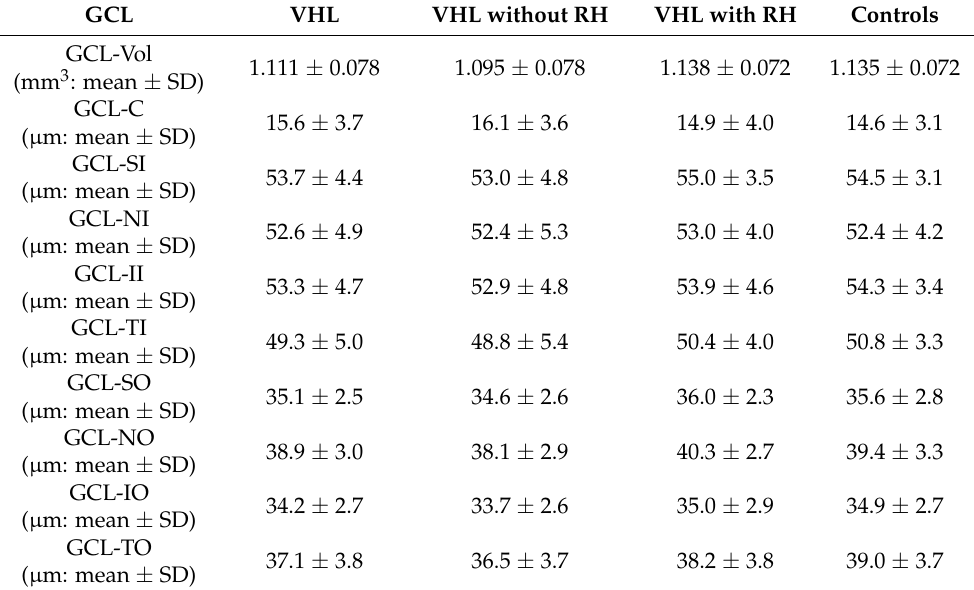
Table 6. Volume and thickness of GCL in the analyzed